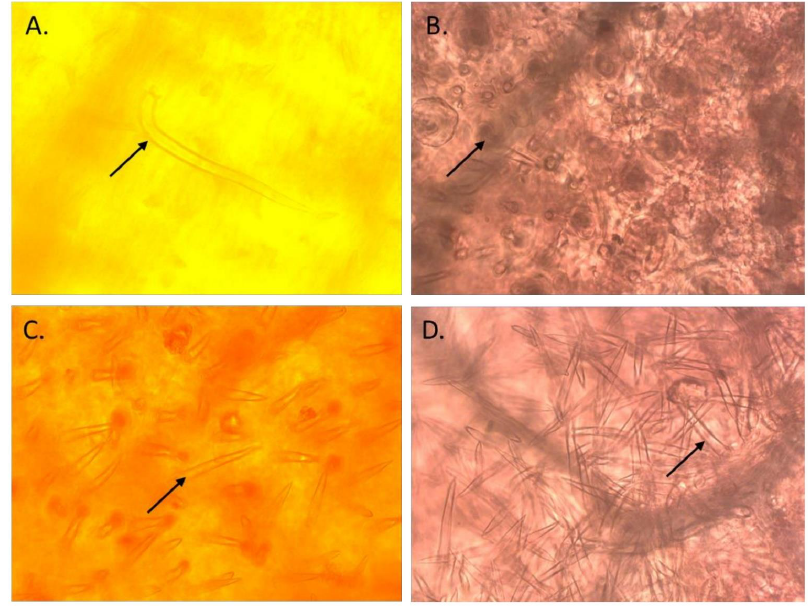
Figure 2. Different types of trichomes observed in the introgression lines of pigeonpea derived from wild Cajanus species. A: Type A trichomes; B: Type B trichomes; C: Type C trichomes; and D: Type D trichomes